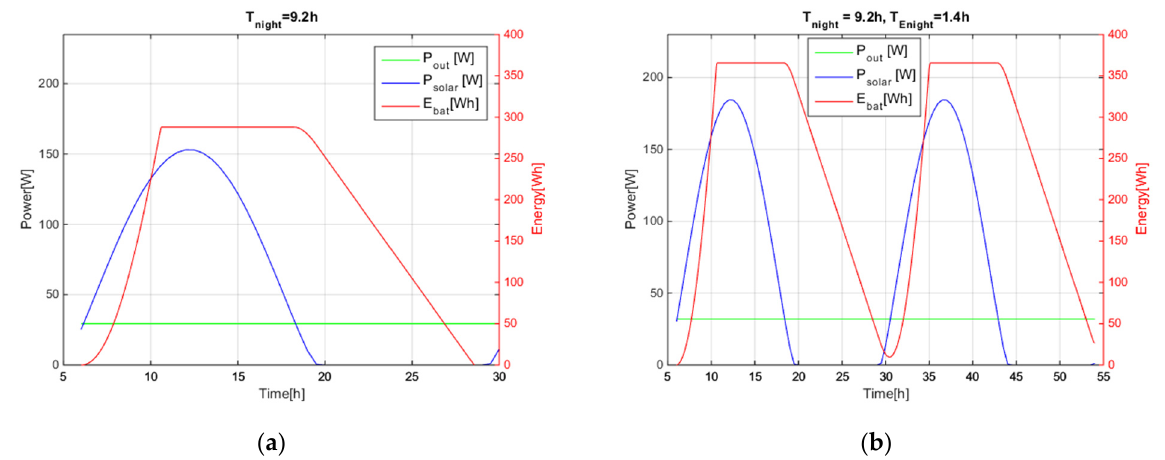
Figure 6. Energy simulation: ( a ) 𝑡 (cid:3041)(cid:3036)(cid:3034)(cid:3035)(cid:3047) = 9.2 h , ( b ) 𝑡 (cid:3041)(cid:3036)(cid:3034)(cid:3035)(cid:3047) = 9.2 h,𝑡 (cid:3006)(cid:3041)(cid:3036)(cid:3034)(cid:3035)(cid:3047) = 1.4 h. Figure 6. Energy simulation: ( a ) t night = 9.2 h, ( b ) t night = 9.2 h, t Enight = 1.4 h.